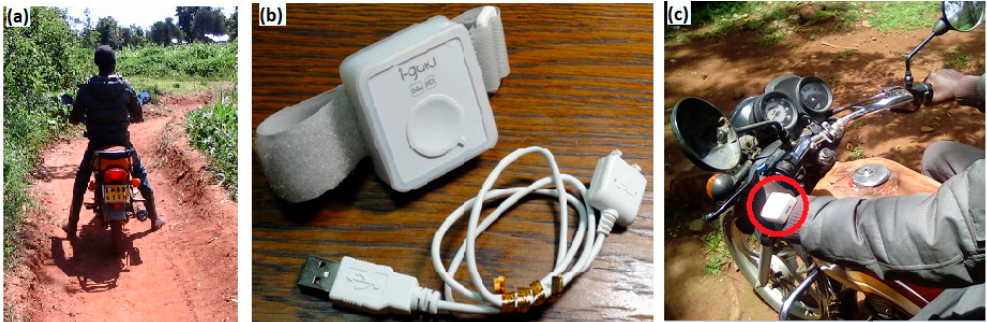
Figure 2. Illustration of ( a ) Typical rural motorcycle tracks ( b ) i-gotU GT-600 Global Positioning System (GPS) travel and sports data logger ( c ) A motor cycle rider strapping a GPS data logger on the wrist while riding a motorcycle taxi.